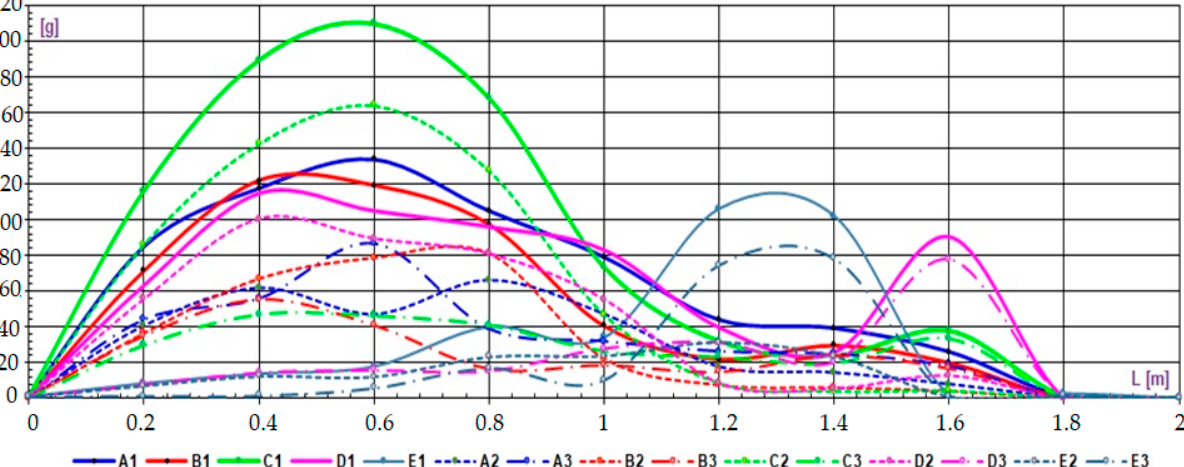
Figure 3. Laboratory instrumentation. ( a ) KERN balance for determining the mass of seeds/straws. ( b ) Memmert oven for determining seed/straw moisture (Author(cid:31)s own pictures).